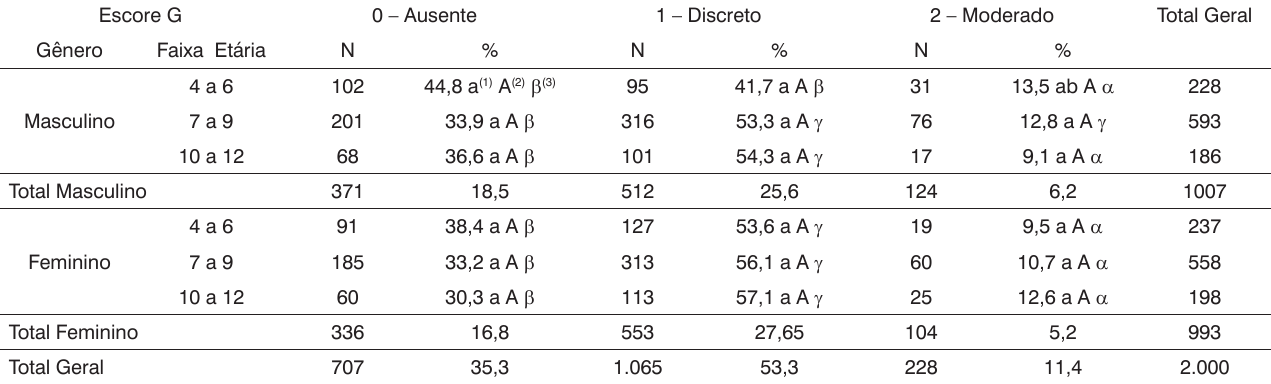
) e correlação com o escore do parâmetro G da 0